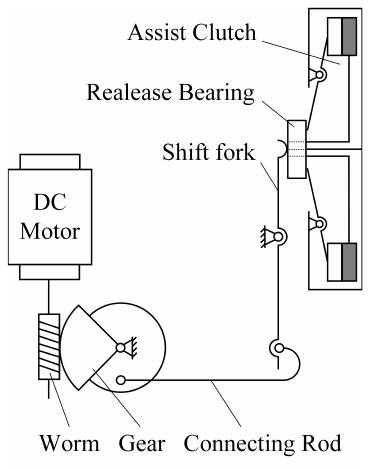
Figure 5. Schematic diagram of the clutch